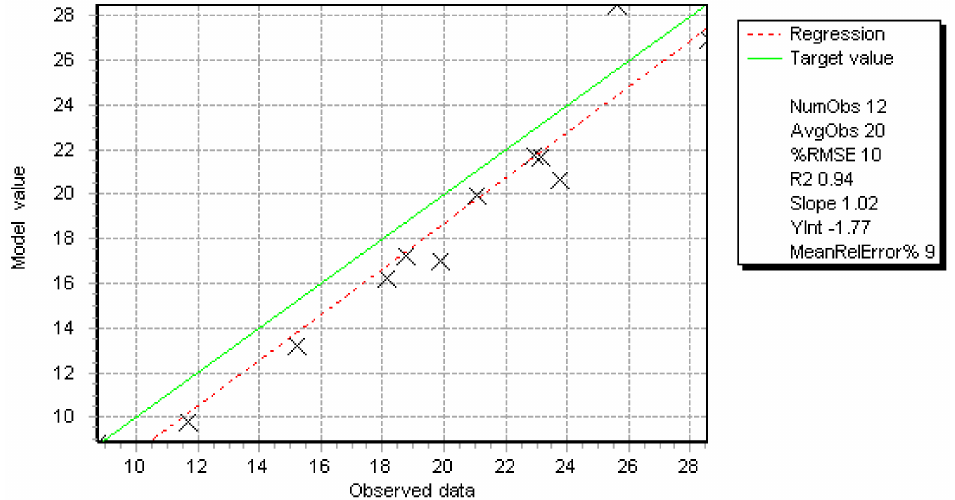
Figure 9. Goodness of fit of the model output data to the observed data from another measurement period for average bicycle